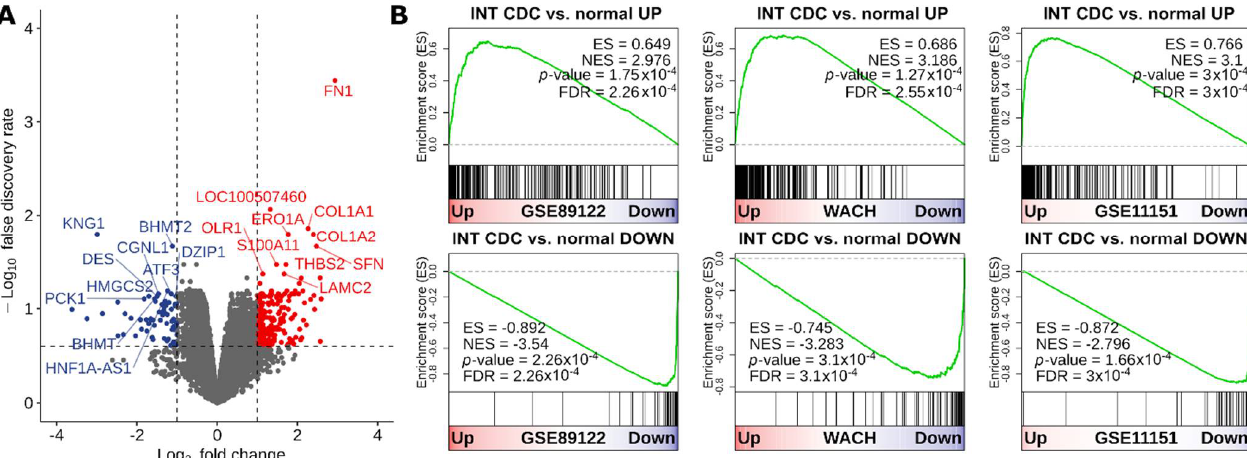
Table 2. List of CDC gene expression datasets analyzed in the study.